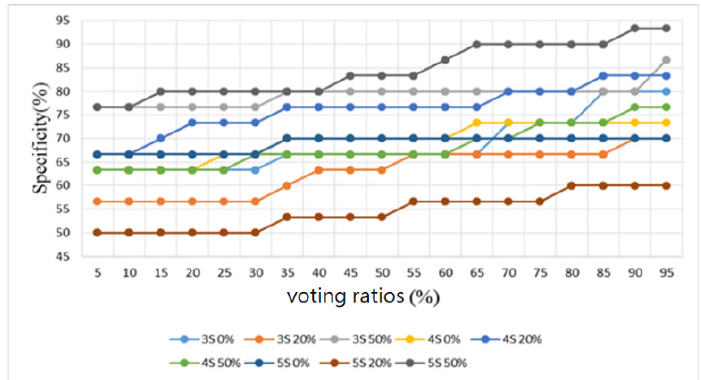
Figure 21. Lung sound classification results: Sensitivity.